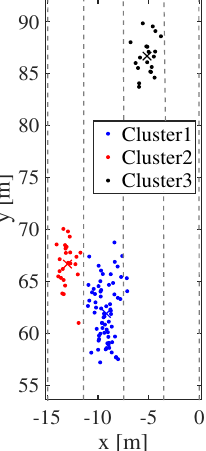
Figure 5. The SDPFC algorithm final clustering